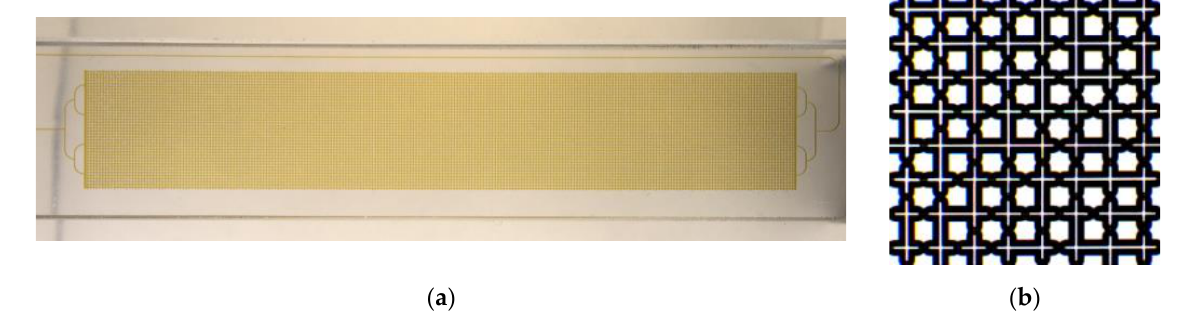
Figure 9. Microfluidic chip ( a ) and its magnified fragment ( b ).